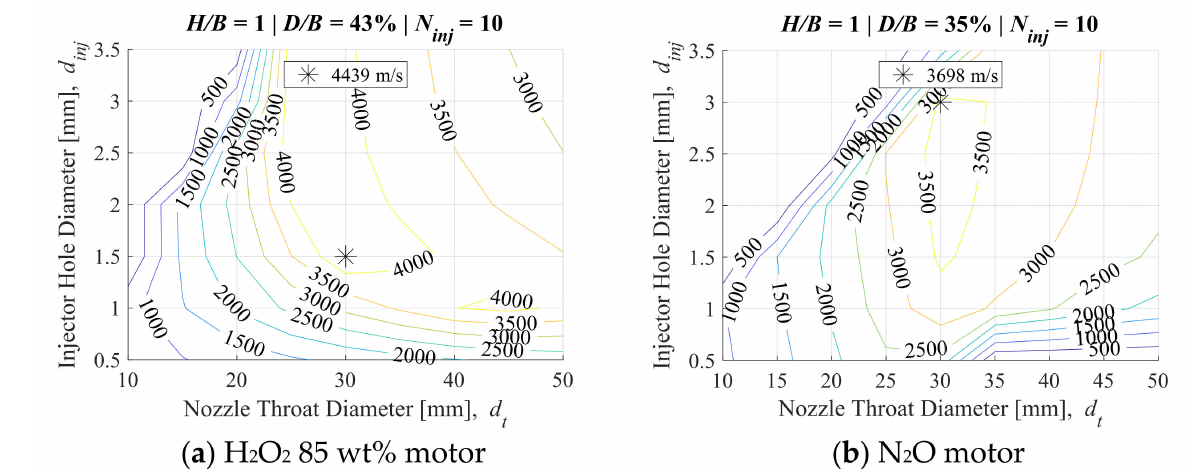
Figure 13. Examples of the ∆ V solutions spaces without nozzle throat erosion.